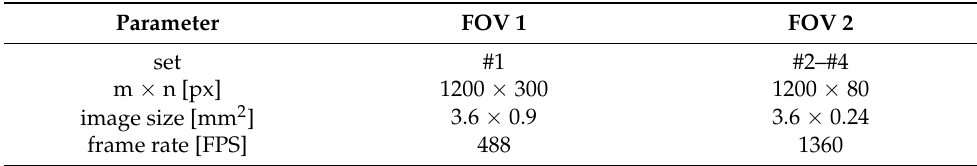
Table 3. Overview of the camera’s FOV in dependence of the analyzed sets.